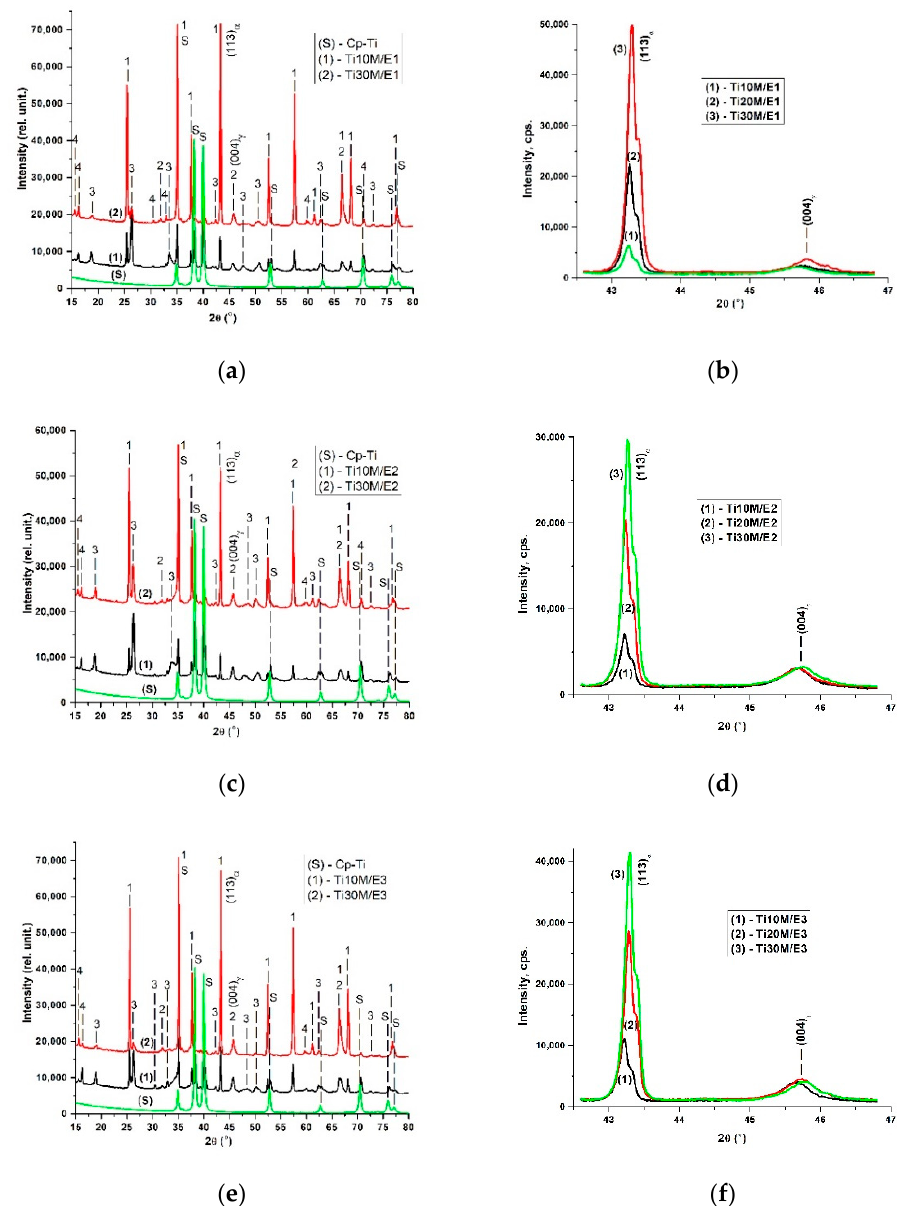
Figure 2. X-ray diffraction patterns of the PEO coatings formed after 10 and 30 min process time in: ( a ) E1; ( b ) E2; ( c ) E3 electrolytes. High-resolution diffraction patterns of the PEO coatings formed after 10, 20 and 30 min process time in: ( d ) E1; ( e ) E2; ( f ) E3 electrolytes. 1: α -Al 2 O 3 (DB card number 04-013-1687); 2: γ -Al 2 O 3 (DB card number 00-050-0741); 3: TiAl 2 O 5 (DB card number 04-011-9497); 4: Na 2 Ti 4 O 9 (DB card number 04-011-2997); S: Cp-Ti grade 2 (DB card number 04-007-9313). The calculated value of the C α /C γ ratio from Equation (1) increased significantly, from ~1 to ~6 for samples treated for 10 and 30 min, respectively. It was found that for